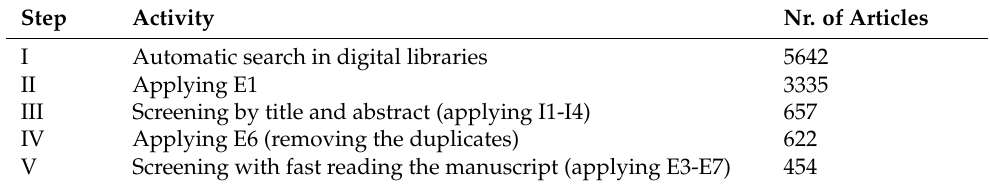
Table 4. Steps in screening and selection of the relevant